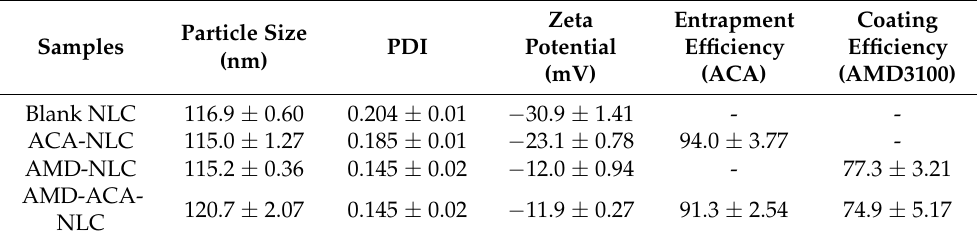
Table 1. Physico-chemical properties of the nanostructured lipid carriers (NLCs). All data are expressed as mean ± SD of three replicates. Particle Samples